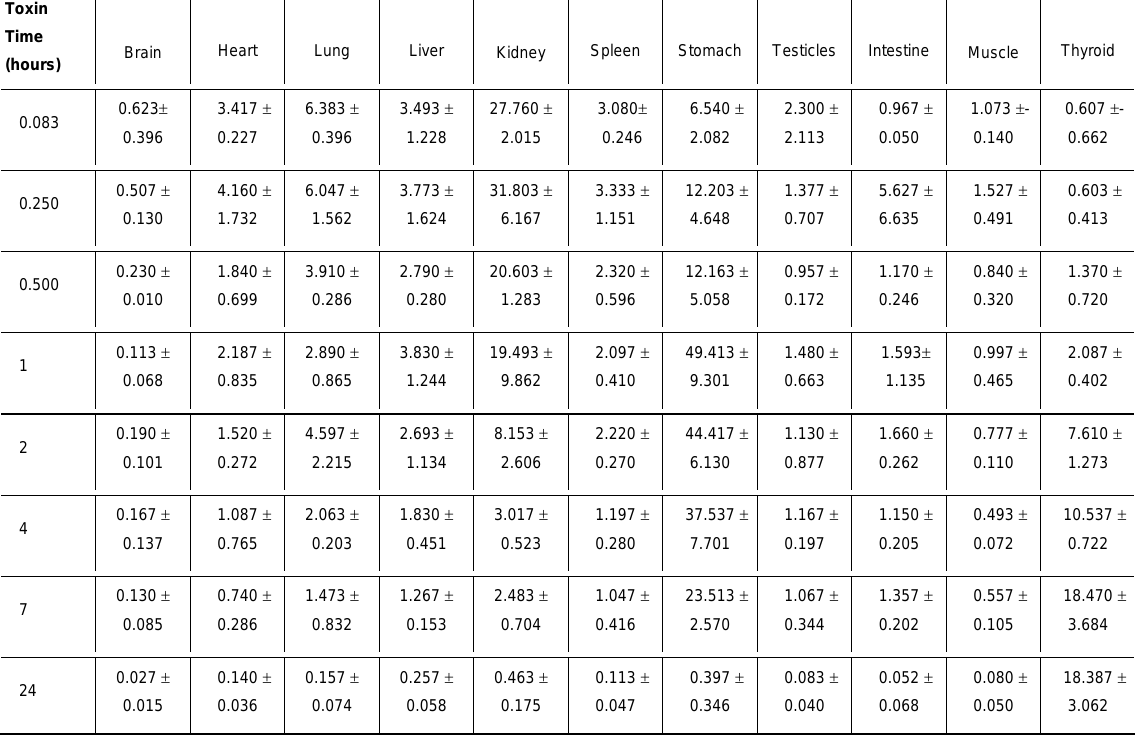
Table 1. 125 I-PnTX2-6 toxin distribution in different organs of mice sacrificed over 24 hours after intraperitoneal administration. Data were expressed as the percentage of total dose injected per tissue weight (% D/g ±